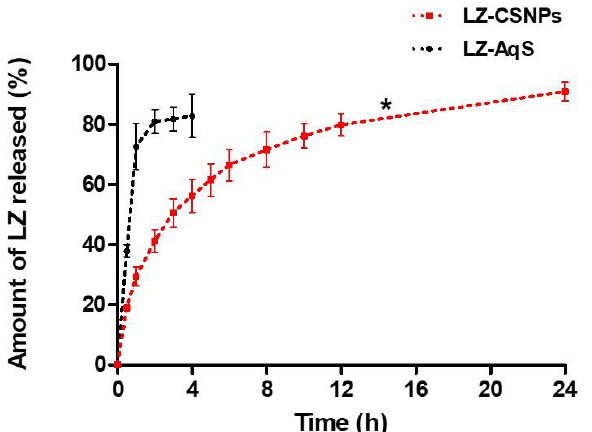
Figure 3. In vitro release of LZ from CSNPs and LZ–AqS in simulated tear fluid (STF) at pH 7.4 through the dialysis membrane. Results were represented as the mean of three measurements with standard deviation (Mean ± SD), The “*” representing p < 0.05 was the level of significance between the two drug